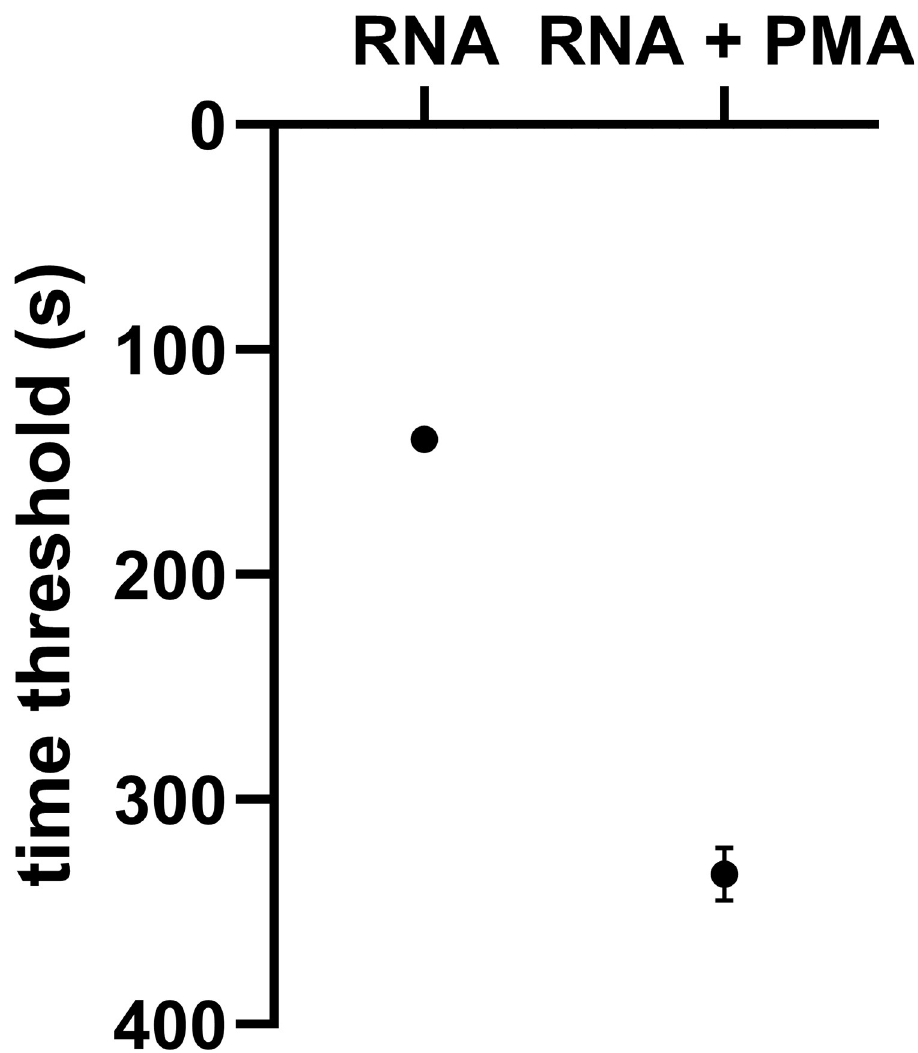
Fig 3. Effect of PMA on free FCoV RNA equivalent to 10 8 TCID 50 /mL. Delay in time threshold after application of PMA was recorded. The difference between RNA and PMA pretreatment was statistically significant (p < 0.001). without pretreatment (Fig 4), which means that the cell culture supernatant contains infectious intact virus particles that cannot be degraded by the universal nuclease.